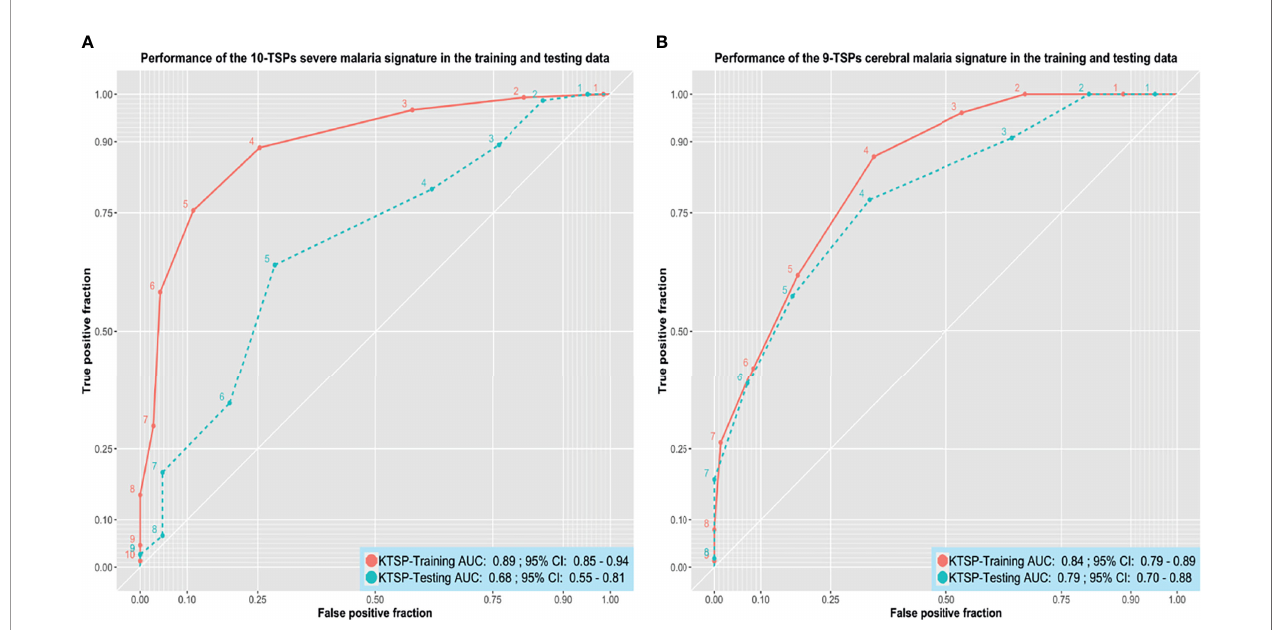
FIGURE 4 | Performance of the K-TSPs severe and cerebral malaria signatures. (A) the performance of the severe malaria 10-TSPs model at distinguishing severe from non-severe malaria. (B) the performance of the cerebral malaria 9-TSPs model at distinguishing cerebral from non-cerebral malaria. Shown are the ROC curves in the training (red) and testing (green) data. The set of genes comprising each signature was divided into up- and down-regulated genes and used to build a K-top scoring pairs (K-TSPs) model with improved interpretability. AUC: area under the ROC